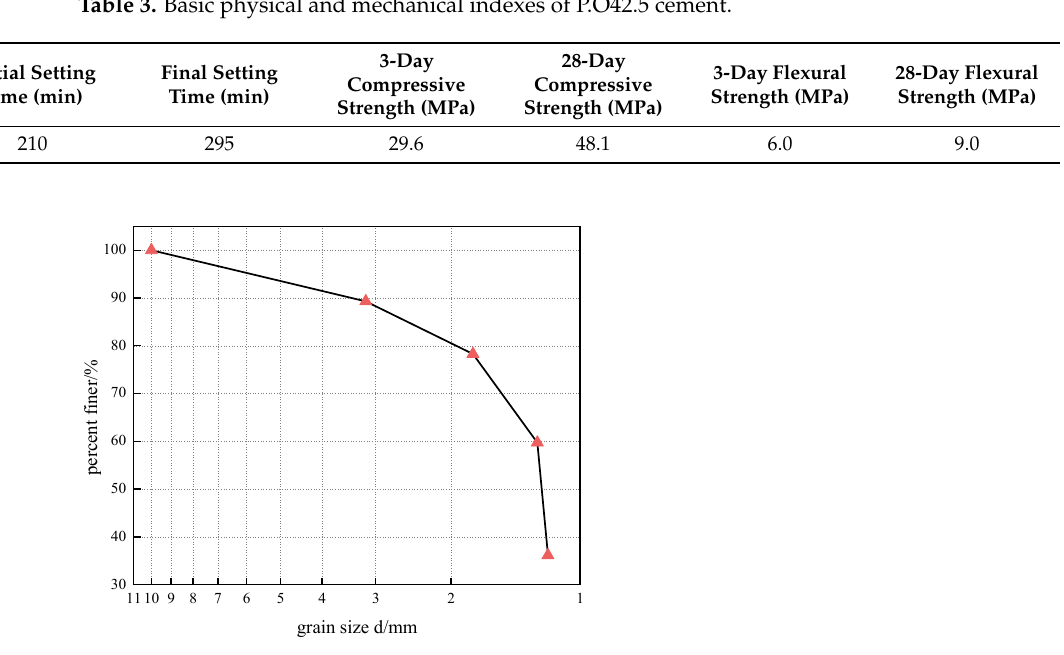
Figure 1. Grain ‐ grading diagram of coastal soft soil with particle size below 2 mm. Figure 1. Grain-grading diagram of coastal soft soil with particle size below 2